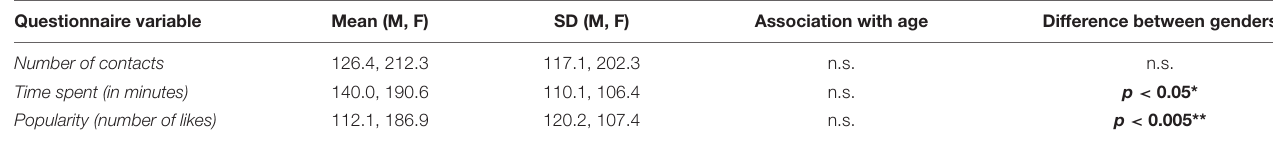
TABLE 2 | Means and standard deviations (SDs) of the social media use (separately for males, M; and females, F) variables, their associations with age, and their differences between genders.